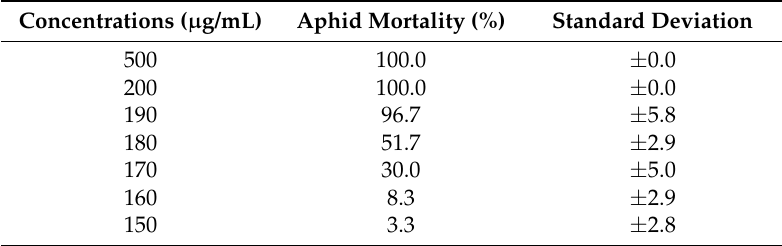
Table 3. Insecticidal activity of chlamyphilone 5 at different concentrations. Treatments were evaluated as mortality (%) of the pea aphid Acyrthosiphon pisum at 72 h after exposure to 5 . Concentrations ( µ